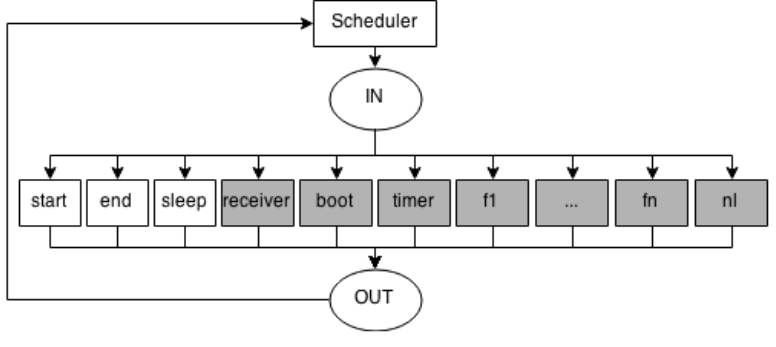
Figure 5. Consumption Scheduler